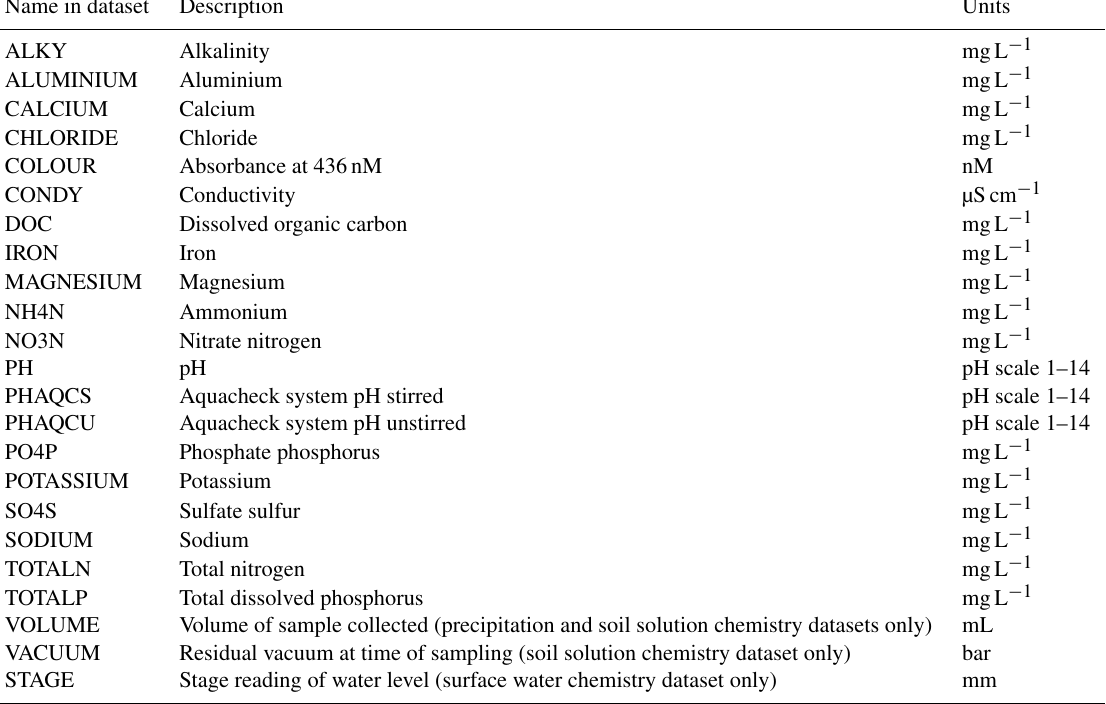
Table 5. Chemical and associated variables (precipitation chemistry, soil solution, surface water